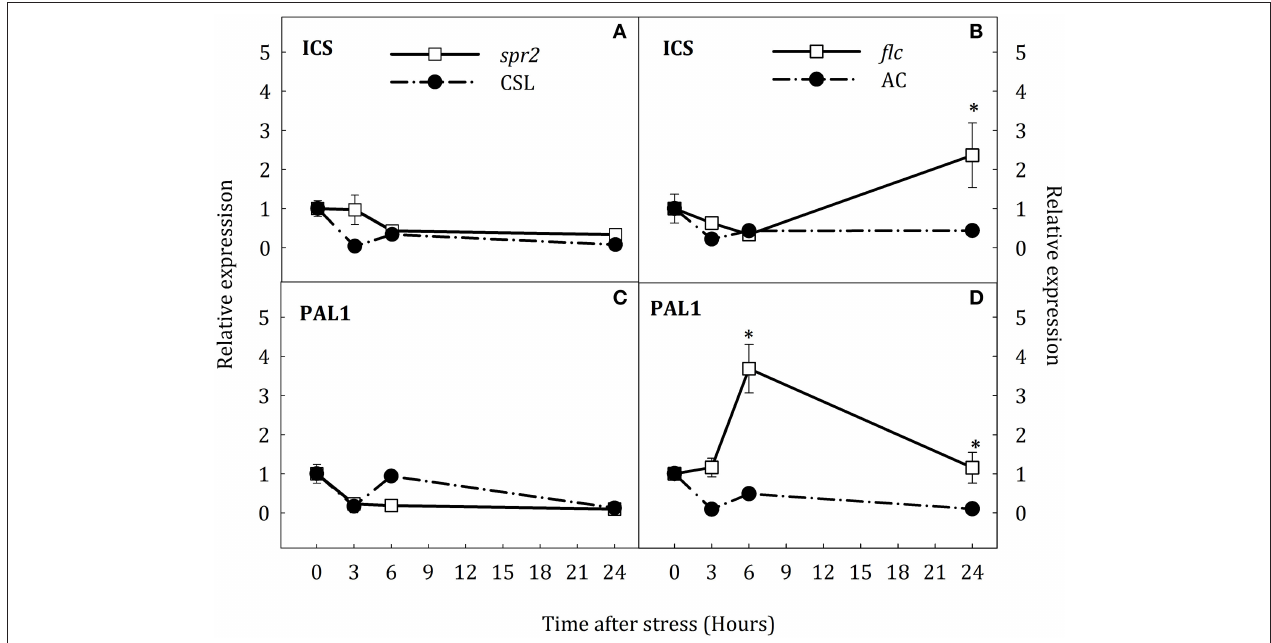
FIGURE 8 | Relative expression of ICS (A,B) and PAL1 (C,D) in leaves of Solanum lycopersicum [WT (CSL and AC, black circles) and mutants ( spr2 and flc , white square)] under control ( t = 0 ) and water-stress conditions. Data are mean values ± standard deviation of three independent determinations. Asterisks denote statistical difference with respect to WT at p ≤ 0.05